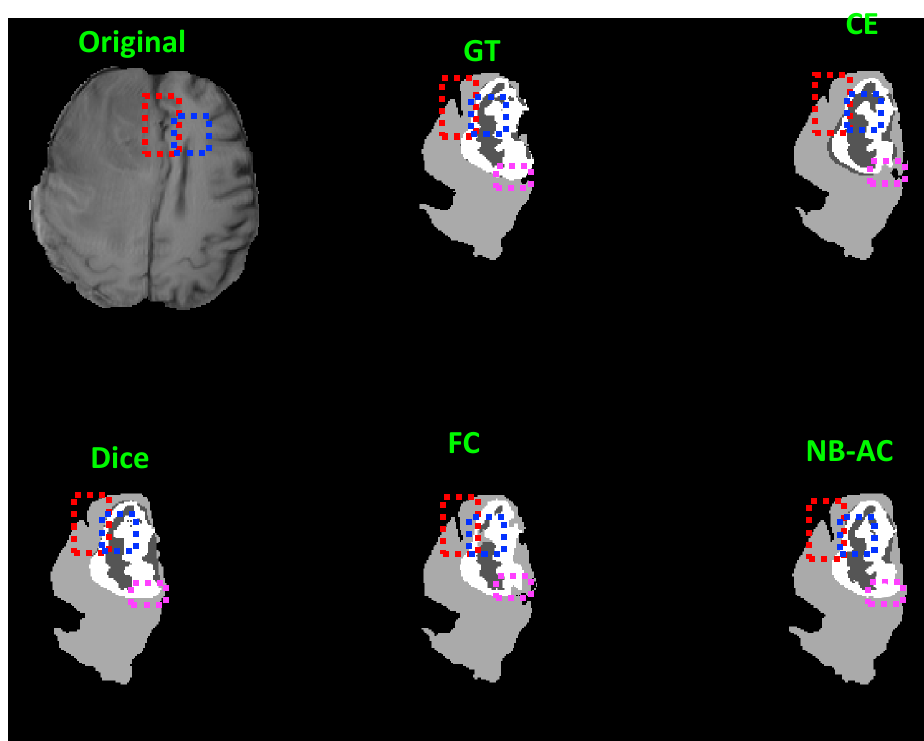
Figure 10. Comparison between our results against other loss functions on Unet framework. The image is from the BRATS 2018